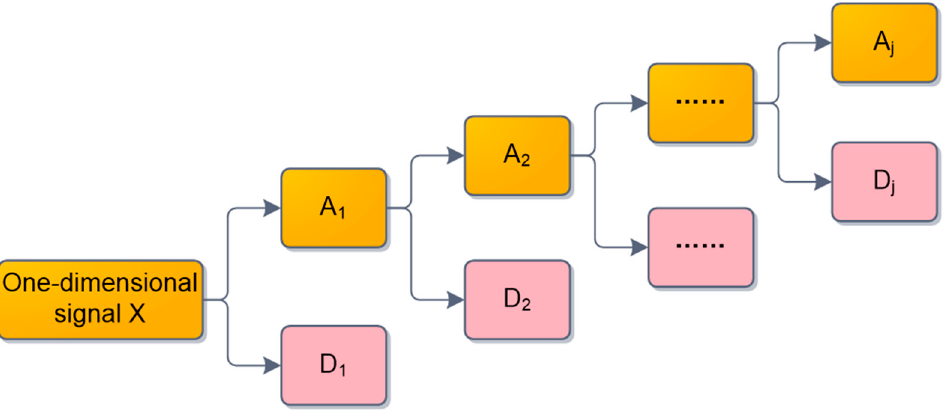
Figure 1. The decomposition process of multi-resolution singular value decomposition (MRSVD).